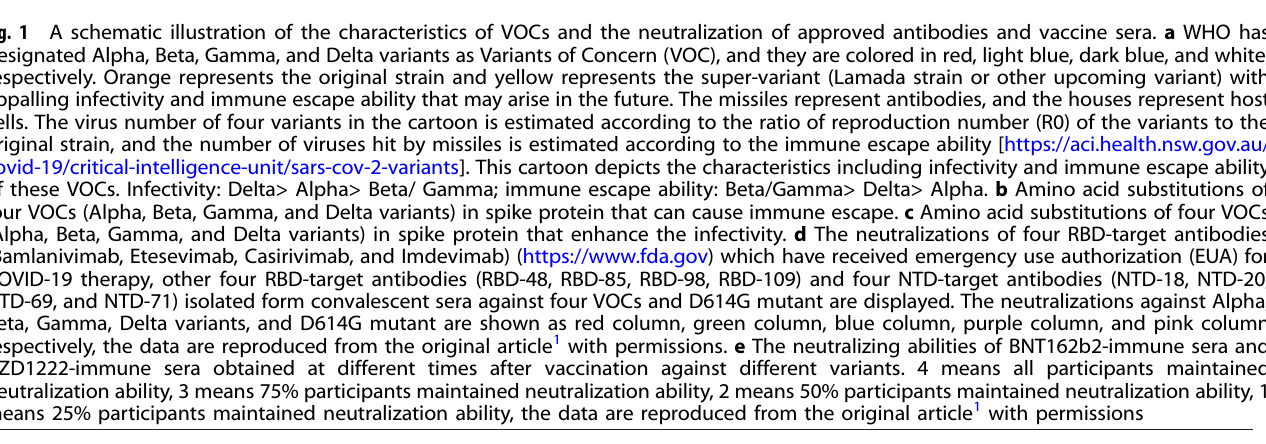
Fig. 1 A schematic illustration of the characteristics of VOCs and the neutralization of approved antibodies and vaccine sera. a WHO has designated Alpha, Beta, Gamma, and Delta variants as Variants of Concern (VOC), and they are colored in red, light blue, dark blue, and white, respectively. Orange represents the original strain and yellow represents the super-variant (Lamada strain or other upcoming variant) with appalling infectivity and immune escape ability that may arise in the future. The missiles represent antibodies, and the houses represent host cells. The virus number of four variants in the cartoon is estimated according to the ratio of reproduction number (R0) of the variants to the original strain, and the number of viruses hit by missiles is estimated according to the immune escape ability [https://aci.health.nsw.gov.au/ covid-19/critical-intelligence-unit/sars-cov-2-variants]. This cartoon depicts the characteristics including infectivity and immune escape ability of these VOCs. Infectivity: Delta> Alpha> Beta/ Gamma; immune escape ability: Beta/Gamma> Delta> Alpha. b Amino acid substitutions of four VOCs (Alpha, Beta, Gamma, and Delta variants) in spike protein that can cause immune escape. c Amino acid substitutions of four VOCs (Alpha, Beta, Gamma, and Delta variants) in spike protein that enhance the infectivity. d The neutralizations of four RBD-target antibodies (Bamlanivimab, Etesevimab, Casirivimab, and Imdevimab) (https://www.fda.gov) which have received emergency use authorization (EUA) for COVID-19 therapy, other four RBD-target antibodies (RBD-48, RBD-85, RBD-98, RBD-109) and four NTD-target antibodies (NTD-18, NTD-20, NTD-69, and NTD-71) isolated form convalescent sera against four VOCs and D614G mutant are displayed. The neutralizations against Alpha, Beta, Gamma, Delta variants, and D614G mutant are shown as red column, green column, blue column, purple column, and pink column respectively, the data are reproduced from the original article 1 with permissions. e The neutralizing abilities of BNT162b2-immune sera and AZD1222-immune sera obtained at different times after vaccination against different variants. 4 means all participants